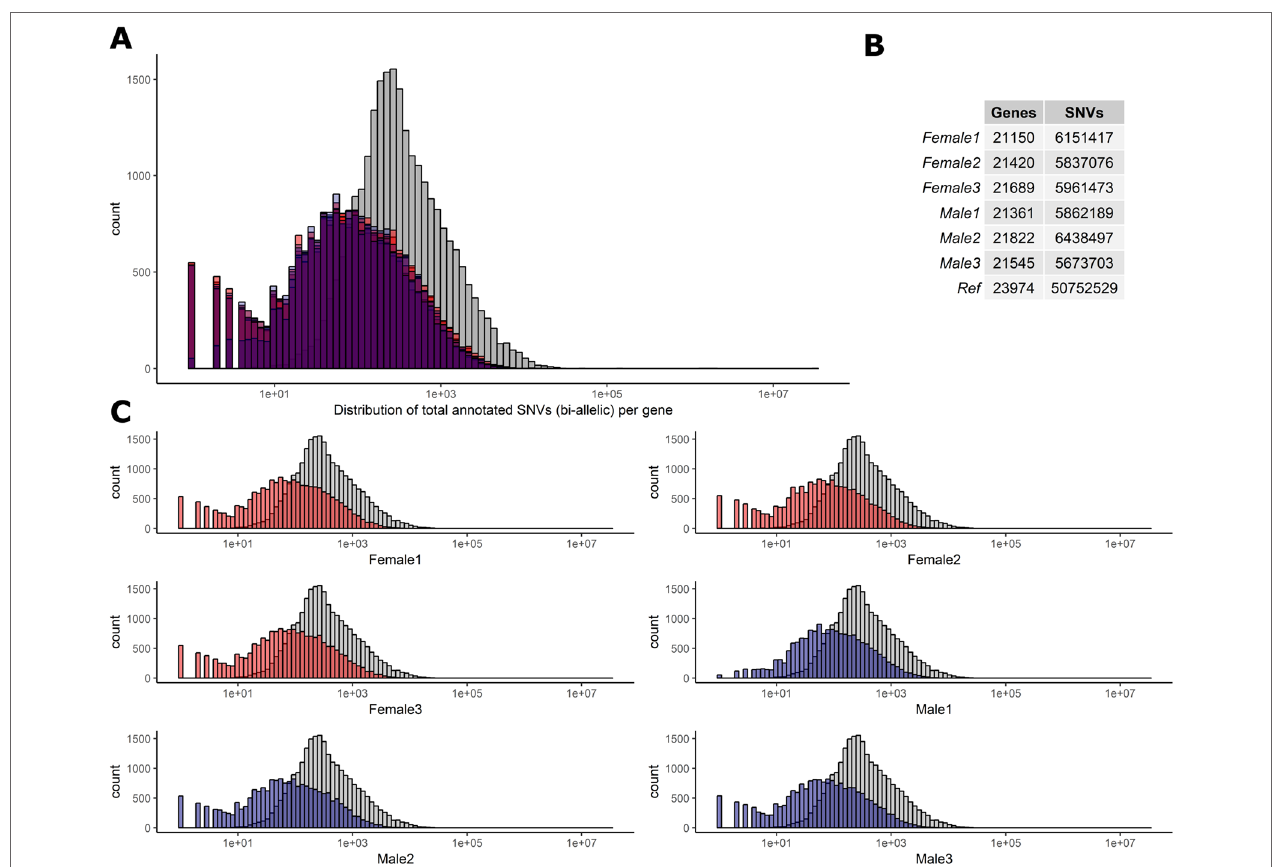
FIGURE 2 | Distribution of biallelic SNVs expressed per gene in each of the six T×BF sheep. The total number of SNVs was averaged across thymus, liver, ileum, and spleen for every animal. Over 5×10 7 SNVs were gathered using Ensembl v.92 VCF track. The total number of SNVs per genes is averaged across four tissue RNA-Seq in each animal (~5.9 × 10 6 ). (A) Histogram of SNVs per gene counts in the reference track (Ensembl in grey) and six sheep in red (females) and blue (males) overlaid. (B) . The overall numbers of genes and SNVs detected in each animal (averaged over four tissues). (C) Individual histograms from section A with females in red and males in